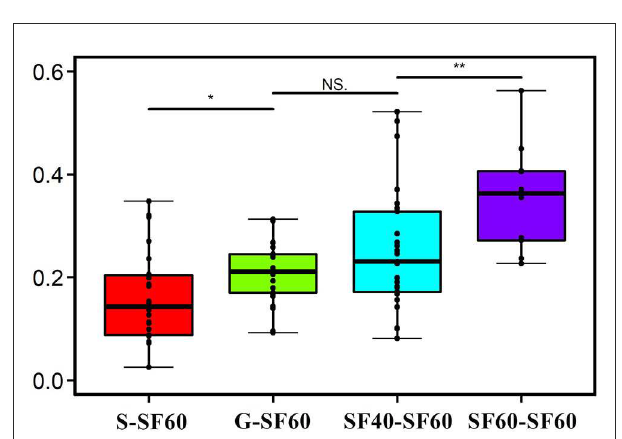
FIGURE2 Bray–Curtis similarity of AMF on the basis of OTUs between other successional stages and secondary forest of 60a. G: grasslands; S: shrubs; SF40: secondary forest of 40a; and SF60: secondary forest of 60a.